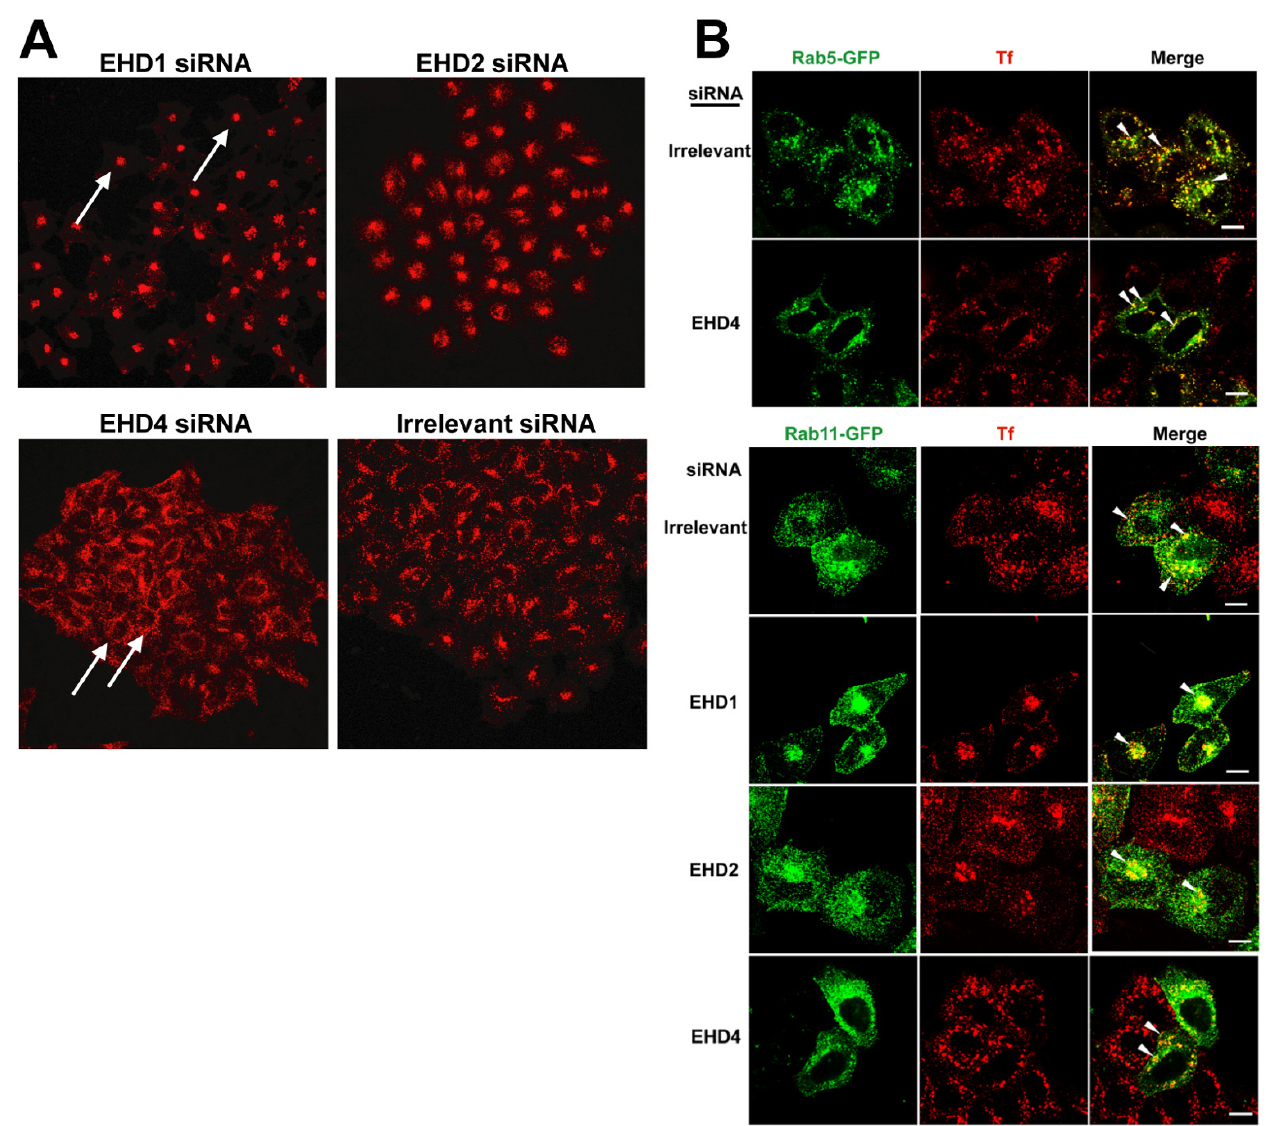
Figure 10 siRNA-mediated EHD protein knock-down effects on transferrin loading in HeLa cells . (A) HeLa cells were seeded on autoclaved glass coverslips in 6-well plates for 24 h followed by transfection of 200 pmol of double-stranded RNA oligonu- cleotides with irrelevant or EHD siRNA for 48 h prior to transferrin loading. Cells were starved for 30 min in starvation media followed by Transferrin-coupled Alexa Fluor 594 in internalization buffer at 37°C for 15 min, washed with ice-cold PBS, fixed and scanned using a confocal microscope equipped with a 40× objective lens. The arrows in the EHD1 siRNA depict an ERC transferrin loading phenotype while the arrows in the EHD4 siRNA depict an EE phenotype. (B) Cells were transfected with siRNA for EHD proteins for 24 h and further transfected with Rab5-GFP or Rab11-GFP for an additional 24 h. Cells were then loaded with labeled transferrin for 15 min as described in Methods. Arrowheads point to colocalized structures. Bar, 10 µ m. Data are representative of 3 individual